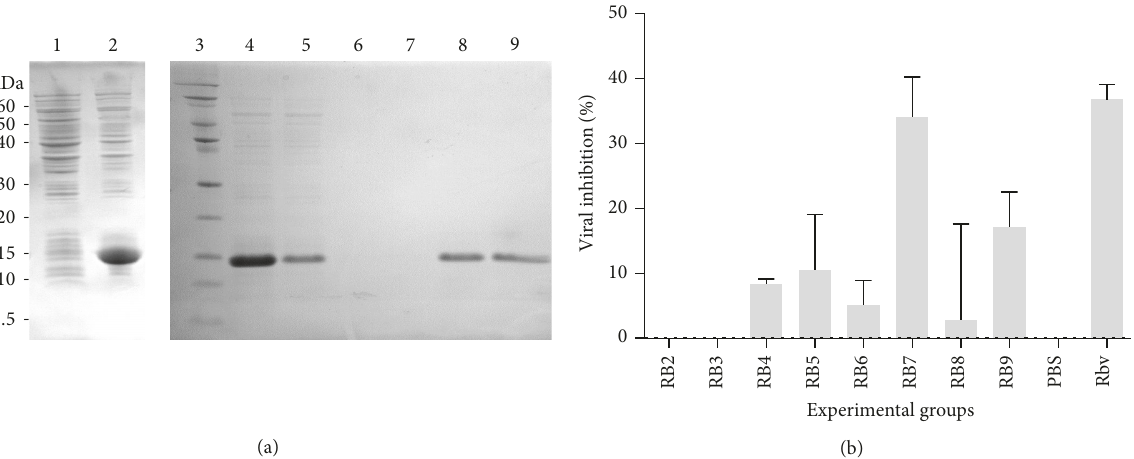
Figure 1: Cloning, expression in E. coli, and purification of codon optimized, dengue 2 envelope domain III. (a) SDS-PAGE showing several steps of protein expression and purification. 1, total lysate of cells before induction; 2, total lysate of cell after IPTG induction; 3, protein molecular weight standards; 4, solubilized inclusion bodies before loading into Ni-NTA column; 5, column flow-through; 6-7, two successive washes; 8-9, two successive elution. (b) Activity of purified and refolded recombinant domain III against DENV2 in Vero cells. Protein was refolded using several refolding conditions (RB1 to RB9) before dialysis and filtration for testing against the virus, in parallel with virus alone and ribavirin as a control. Data is presented as the mean and SD of two independent experiments. Condition RB1 was not used in this experiment as protein consistently